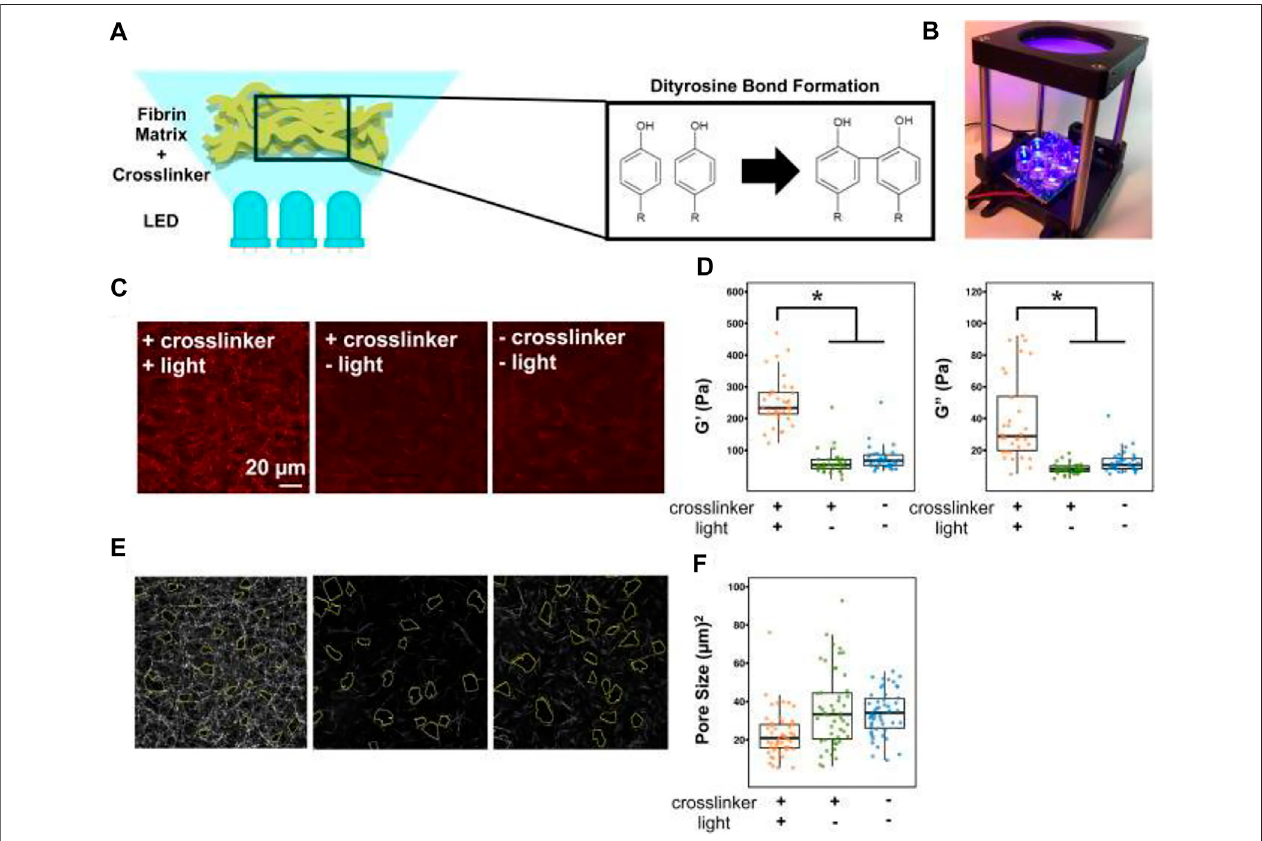
FIGURE 6 | Viscoelastic and pore size characterization of fi brin gels. (A) Experimental schematic and (B) setup of photo-crosslinking process using 465 nm blue light. (C) Backscattermicrographsof2 mg/ml fi bringelsatthreedifferentconditions.Scalebaris20microns. (D) Activemicrorheologyscatterplotsofmeasuredstorage (G ′ ) and loss (G ″ ) moduli using given conditions. The asterisk indicates p < 0.05 using the Mann-Whitney test with Bonferroni correction. (E) Micrograph with corresponding pore sizes outlined and (F) pore size scatterplots of the fi brin gels. Figure reproduced from Hsieh, Jessica Y., et al. “ Matrix crosslinking enhances macrophage adhesion, migration, and in fl ammatory activation, ” APL Bioengineering 3, 016103 (2019) https://doi.org/10.1063/1.5067301, with the permission of AIP Publishing.